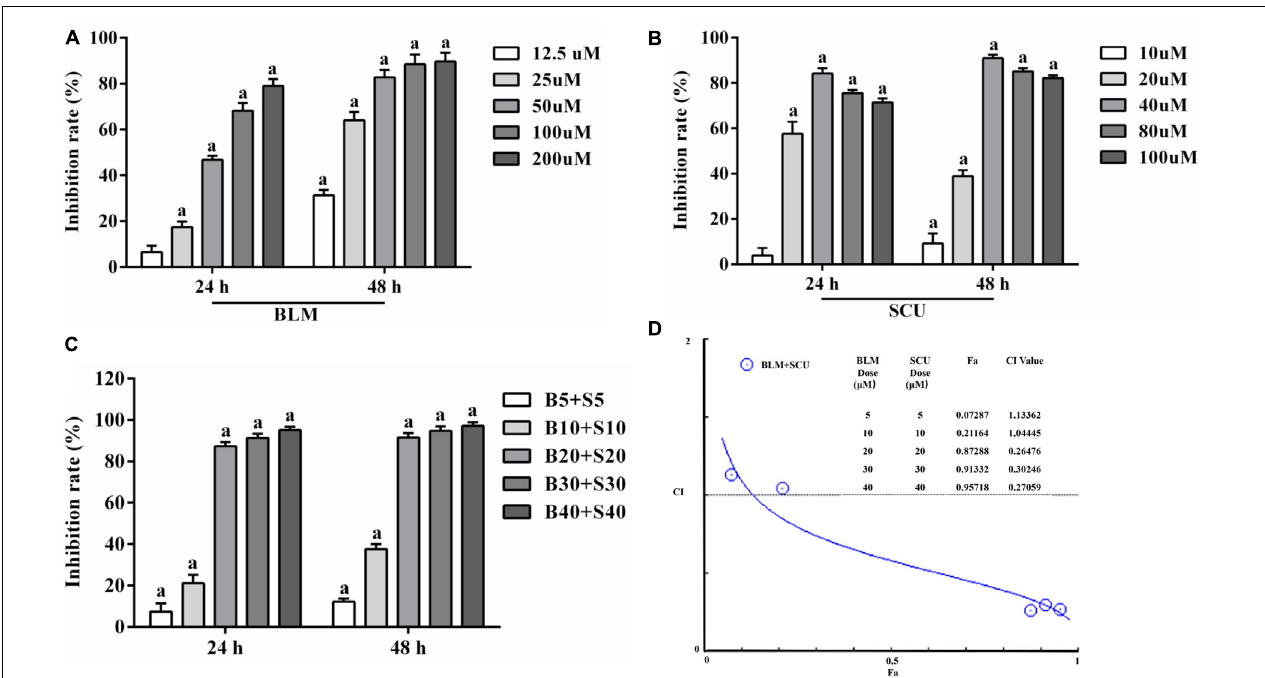
FIGURE 2 | Effects of BLM, SCU, and their combination on the H22 cells. (A) The inhibitory rate of BLM on H22 cells after 24 and 48 h. (B) The inhibitory rate of SCU on H22 cells after 24 and 48 h. (C) The inhibitory rate of BLM combined with SCU on H22 cells after 24 and 48 h. The inhibitory rate = 1 – (OD Experimental – OD Blank /OD Control – OD Blank × 100%). (D) The combination index (CI) values were determined. CI vs. fraction affected (Fa) plots were analyzed with CompuSyn 2.0 software. Data are expressed as the mean ± SD. ( n = 5). a < 0.05 compared with control group.